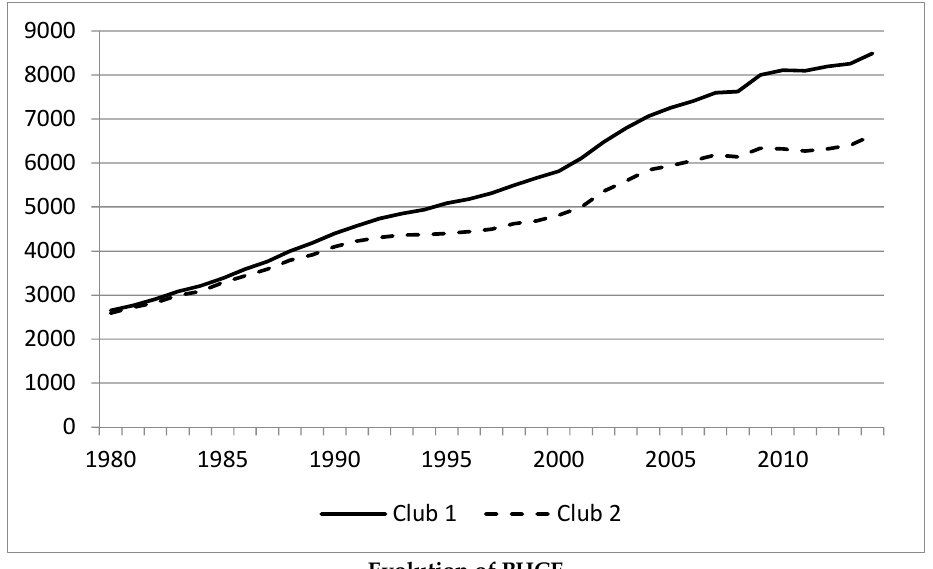
Figure 2. Average values of the PHCE of the states in Club 1 and Club 2 when the 1980–2014 sample is considered.